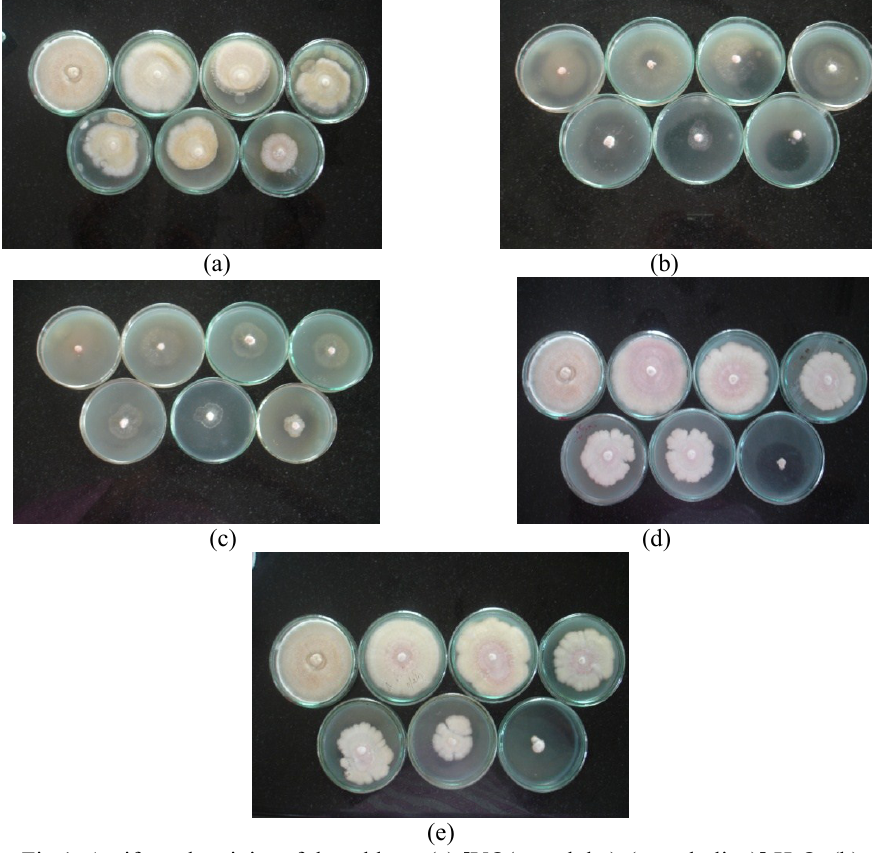
Fig.1 .Antifungal activity of the adducts (a) [VO(morphdtc) Ni(morphdtc) Cu(morphdtc)